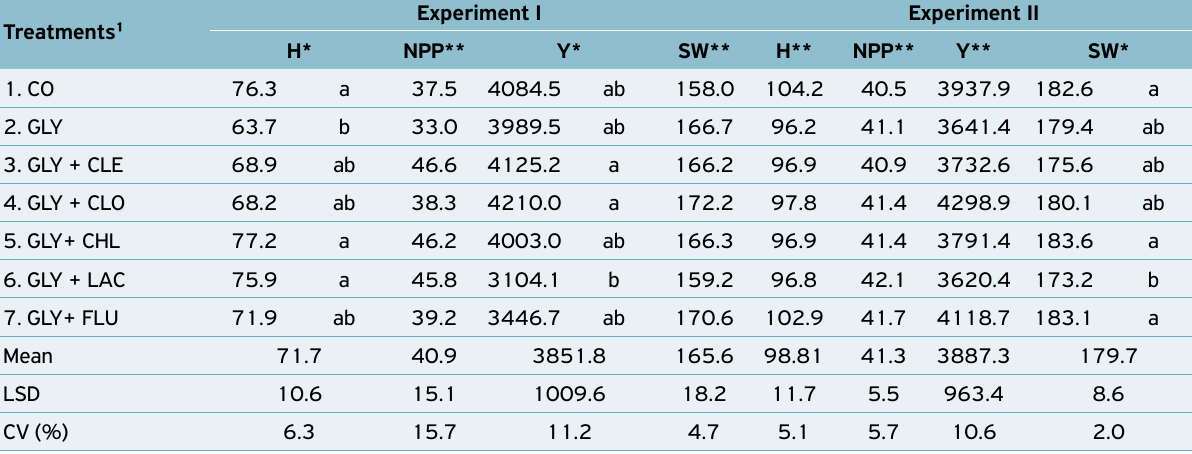
Table 6. Variables related to the agronomic performance² of RR2 soybean subjected to application of glyphosate, alone or in combination, at post‑emergence (V4). Piracicaba, state of São Paulo, 2013/14 season (experiment I), and 2014/15 season (experiment